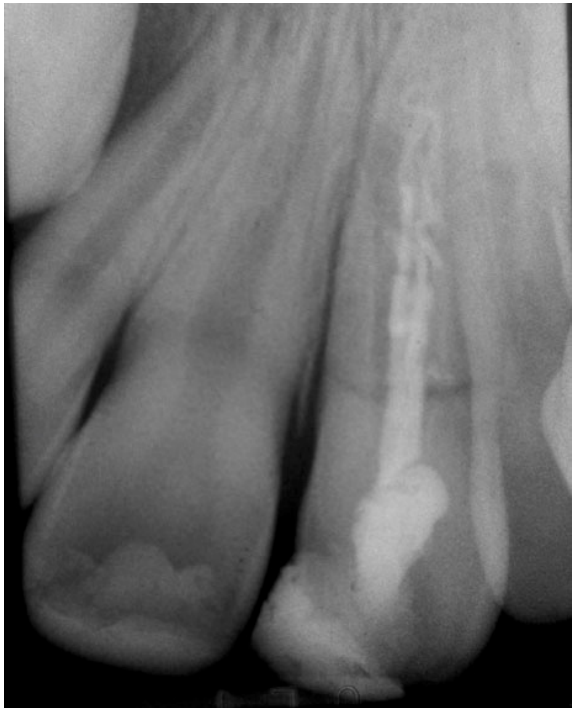
Figure 2. Initial situation at the first trauma, periapical radiograph.